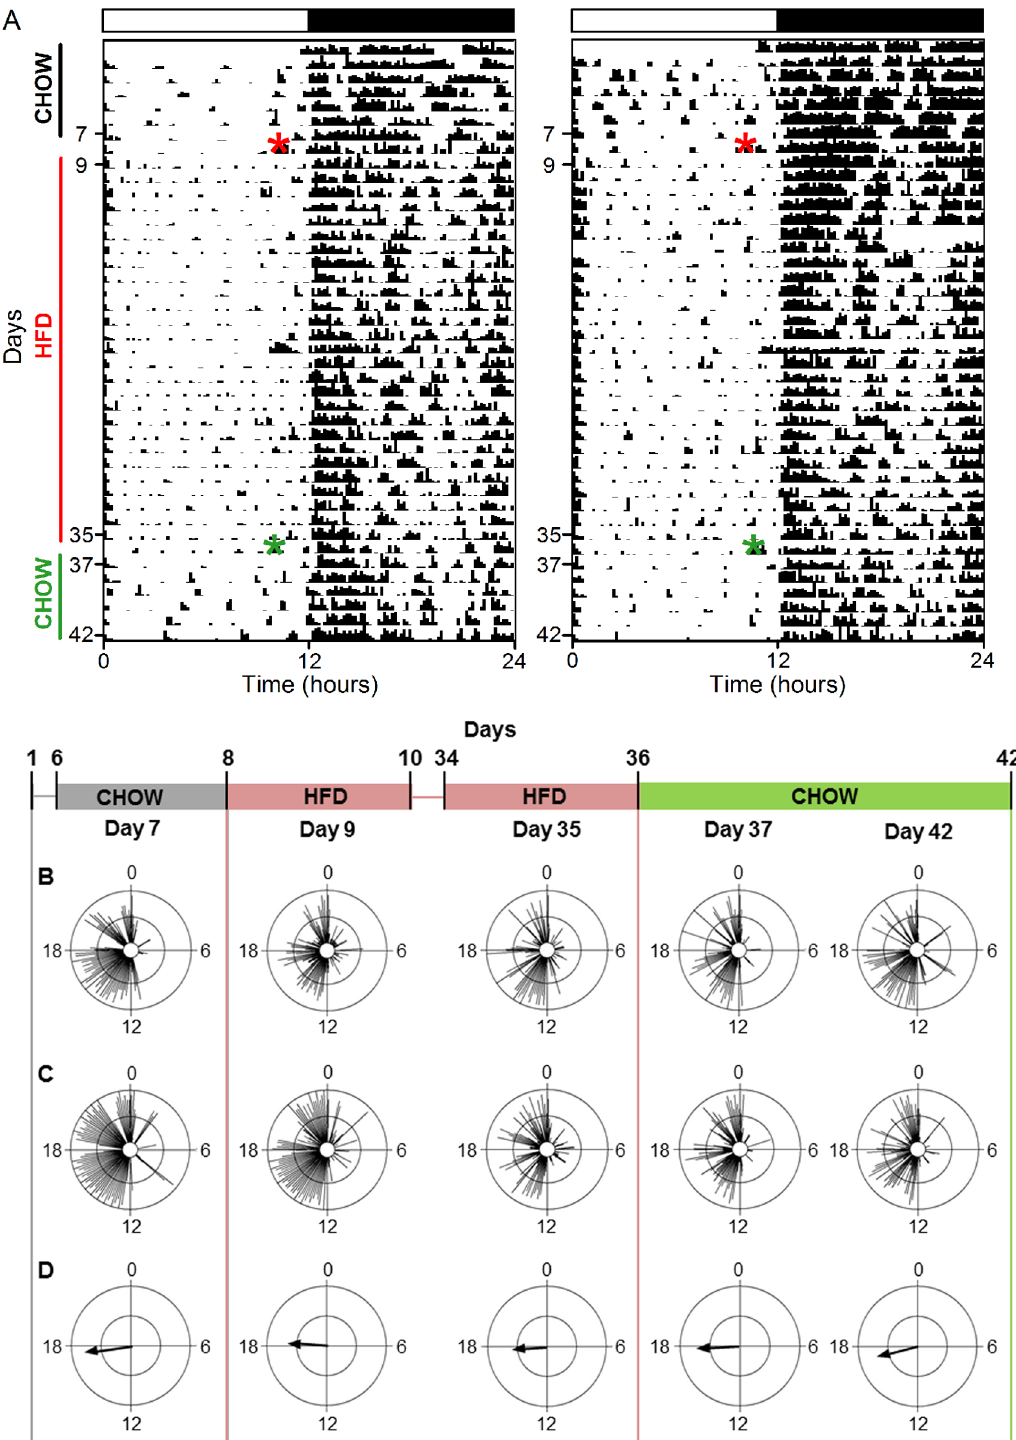
Fig 5. The reversibility of high-fat diet disruption of locomotor activity rhythms is variable. A. Representative actograms of locomotor activity plotted in 10-min bins. Chow was replaced with high-fat diet (HFD; red asterisk) on day 8 and HFD was replaced with chow (green asterisk) on day 36. B, C. Representative circular histograms of activity (10-min bins) in 2 individual mice during one day of chow (day 7), 4 weeks of HFD consumption (days 9, 35), and upon return to chow (days 37, 42). Scale: inner circle, 0; middle circle, 5; outer circle, 10. C. Grand mean vectors of locomotor activity (n = 5). Scale: inner circle, 0; middle circle, 0.3; outer circle, 0.6. Lights were on from 0 – 12. Circular statistics are shown in Table 2.